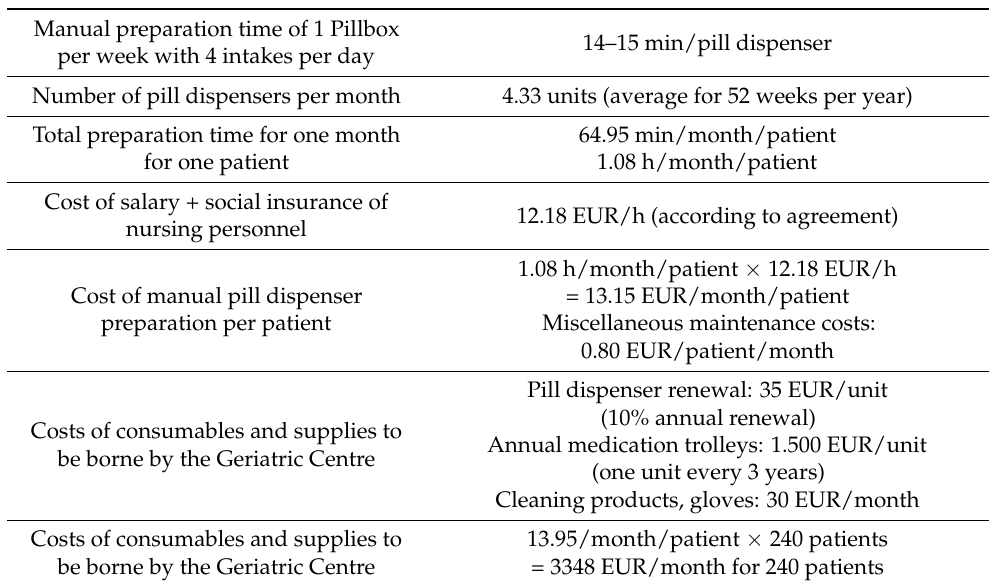
Table 2. Economic study for the manual preparation of weekly pill dispensers for 240 residents of the Ciudad Jard í n centre.